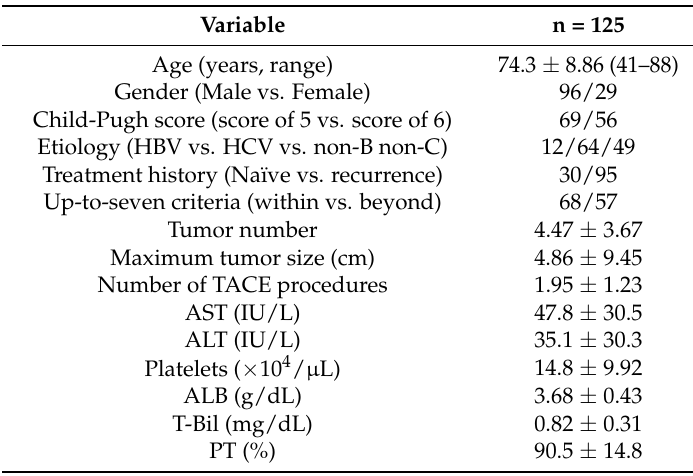
Table 1. Baseline patient